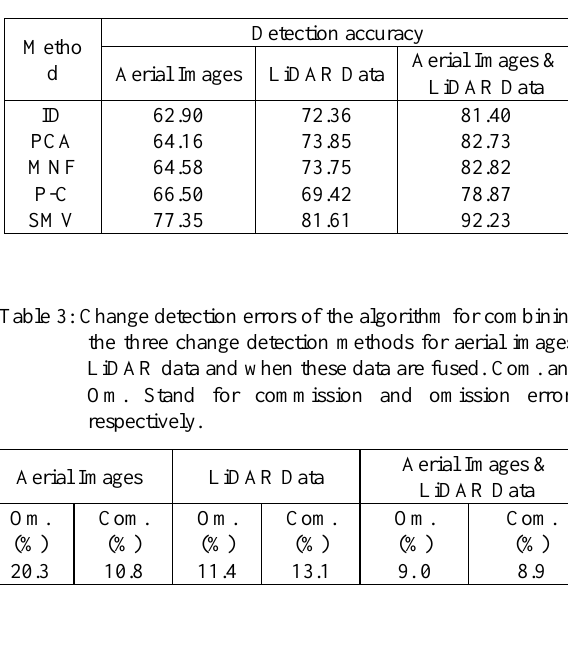
Table 2: Overall detection accuracy for single detection techniques compared with results when they are used in combination (SMV).